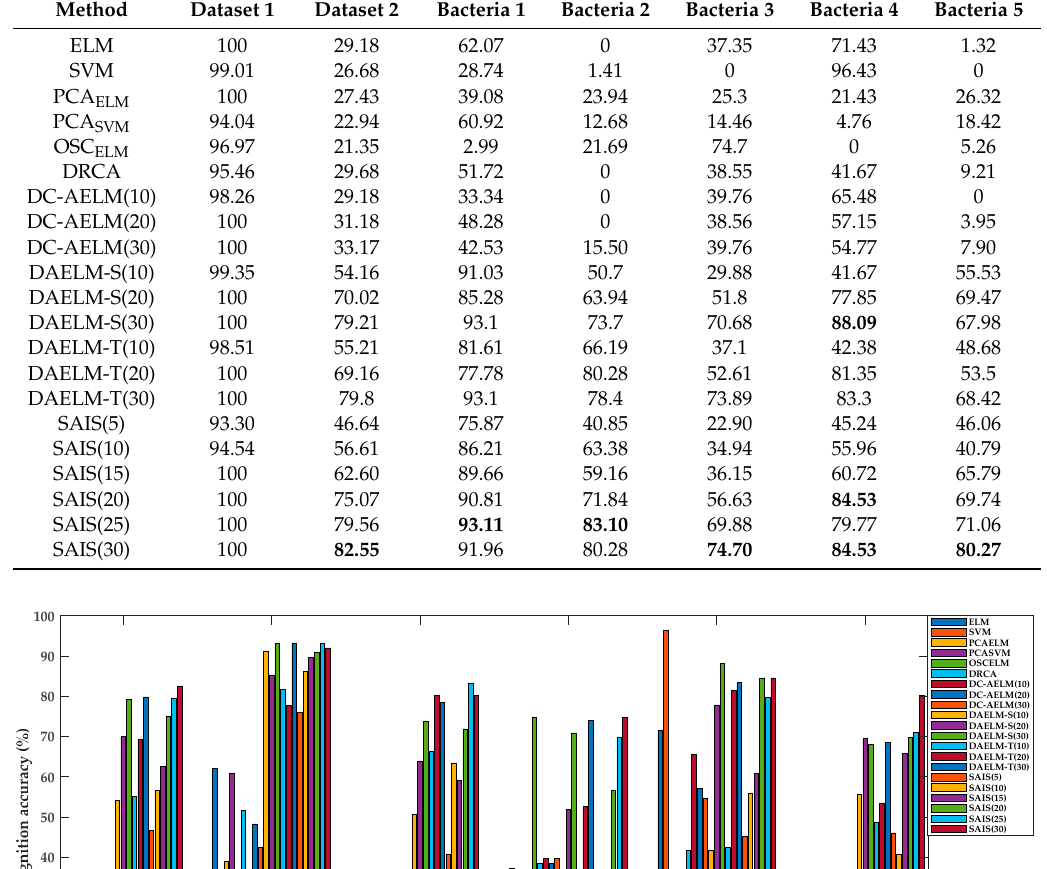
Table 4. Recognition rate (%) for each method.